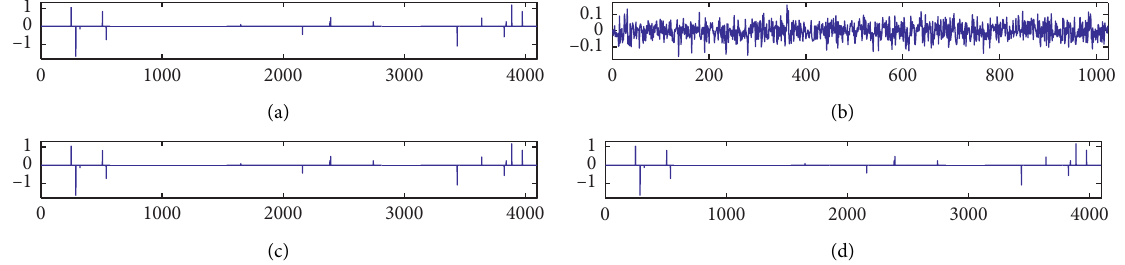
Figure 4: From top to bottom: the original signal, the measurement, and the reconstructed signal by two algorithms. (a) Original ( n � 4096, number of nonzeros � 16), (b) measurement, (c) LJJ CGPM (MSE � 3.81 e − 07, Iter � 42, time � 0.66 s), and (d) PDY (MSE � 3.21 e − 07, Iter � 61, time �